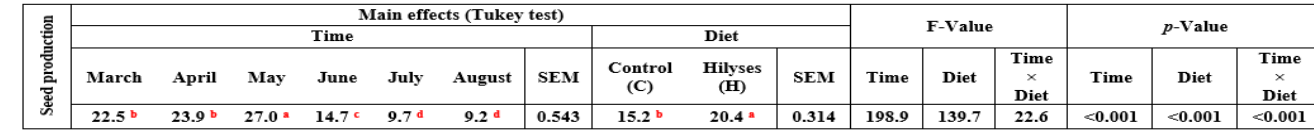
Figure 3. Mortality in Hilyses and control groups over the period of six months (spawning season) starting from March to August. The results were statistically analyzed by using two-way analysis of variance (ANOVA) with type of diets and time as factors, followed by Tukey’s HSD test for mean multi-comparison test. Significance was determined at p < 0.05. a, b, c, d Means with different superscripts are significantly different (P ˂ 0.05). 3.2. Hematological and Biochemical Parameters The Hilyses-treated group showed a significant increase in erythrocyte count, hema- tocrit value, hemoglobin concentration and blood indices, such as the mean corpuscular